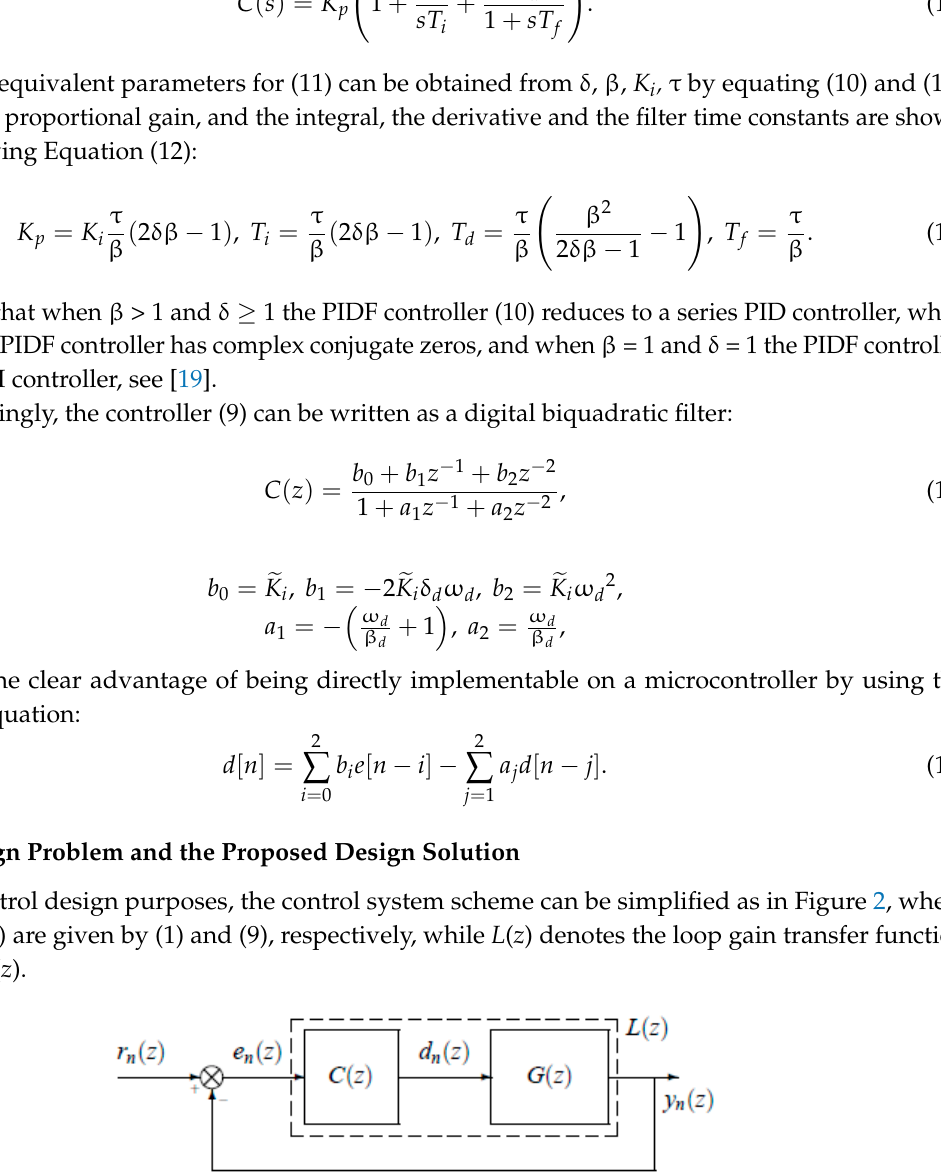
Figure 2. Block scheme of the digital control system.